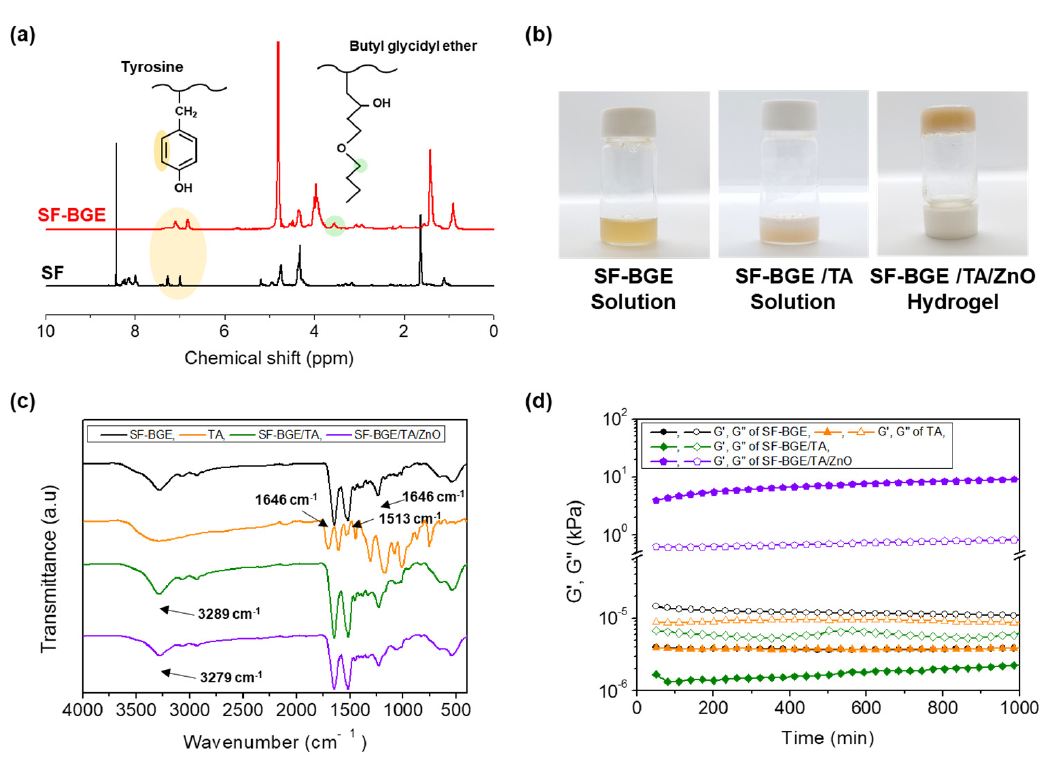
Figure 2. ( a ) 1 H NMR spectra of pristine SF and SF-BGE. ( b ) Photographs demonstrating of SF-BGE and SF-BGE/TA solutions and SF-BGE/TA/ZnO hydrogel. ( c ) ATR-FTIR spectra of SF-BGE, TA, SF- BGE/TA, and SF-BGE/TA/ZnO hydrogel. ( d ) G ′ and G ″ of SF-BGE, TA, SF-BGE/TA, and SF- BGE/TA/ZnO hydrogel.